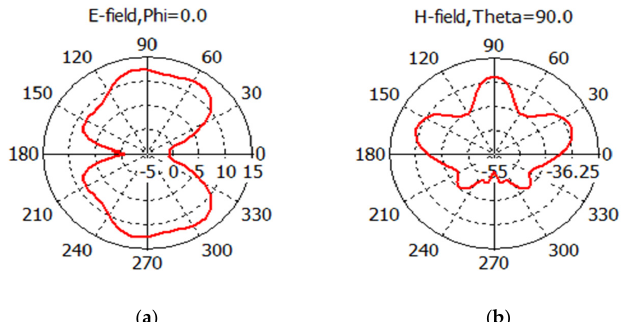
Figure 7. ( a ) E-plane radiation pattern at 26 GHz; ( b ) H-plane radiation pattern at 26 GHz.